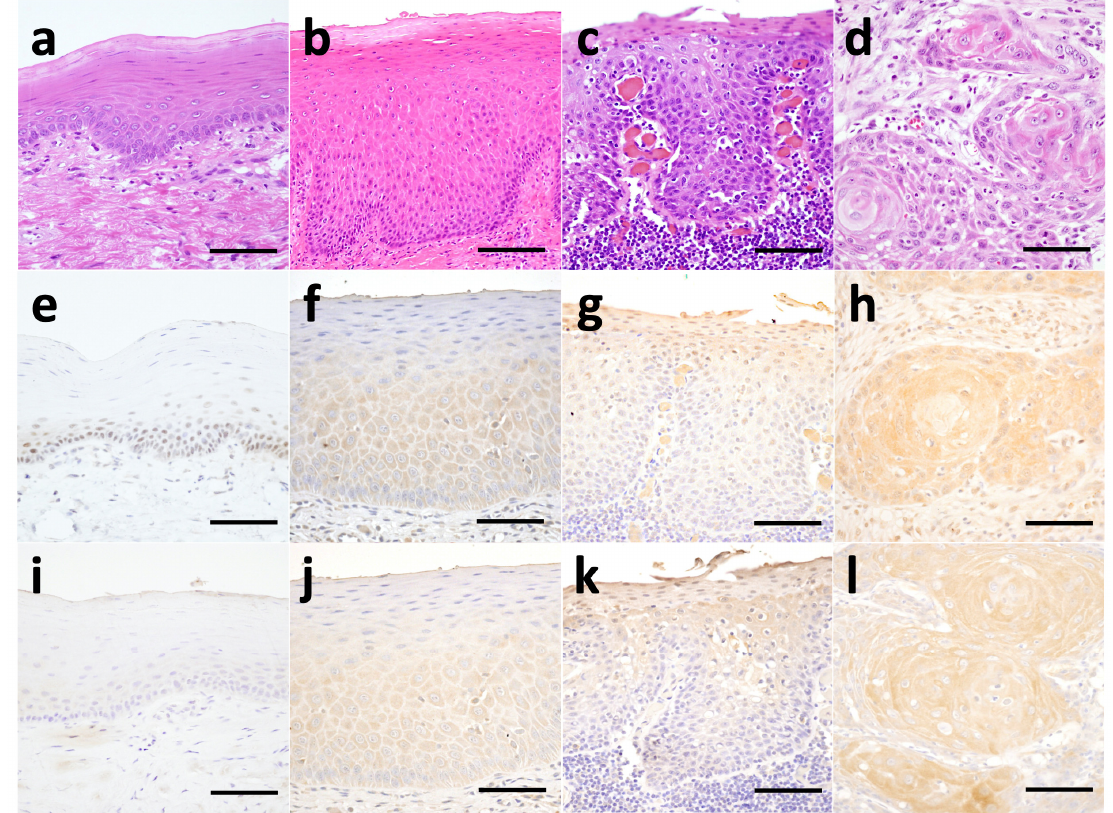
Figure 1. Histopathological features of normal oral mucosa (NOM) ( a ), low-grade epithelial dysplasia (LED) ( b ), high-grade epithelial dysplasia (HED) ( c ), and oral squamous cell carcinoma (OSCC) ( d ). Immunohistochemical staining for MIA and MIA2 in NOM, LED, HED, and OSCC. MIA staining in NOM ( e ), LED ( f ), HED ( g ), and OSCC ( h ). MIA2 staining in NOM (not positive) ( i ), LED ( j ), HED ( k ), and OSCC ( l ). MIA was localized within the nuclei from the basal to lower prickle cell layers in NOM. In LED, HED and OSCC, MIA and MIA2 were mainly localized within the cytoplasm in epithelial cells, LED was observed from the basal to upper prickle cell layers, and OSCC was observed in cell nests. MIA and MIA2 expression were observed up to the epithelial surface in some HED. Scale bar, 100 µ